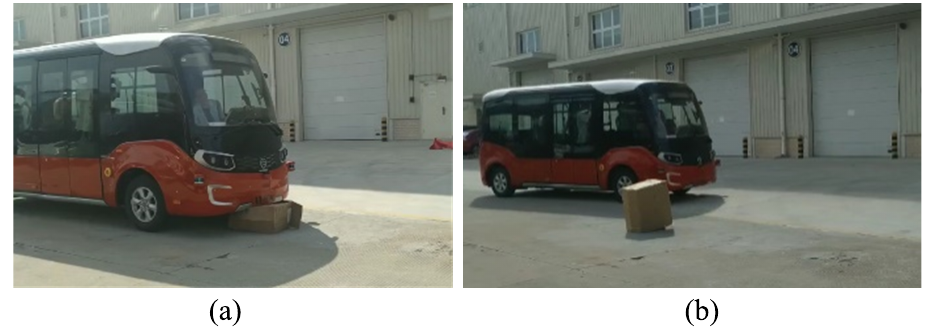
Figure 7. The field test under functional failure (one obstacle): (a) One executor; (b) DHR architecture